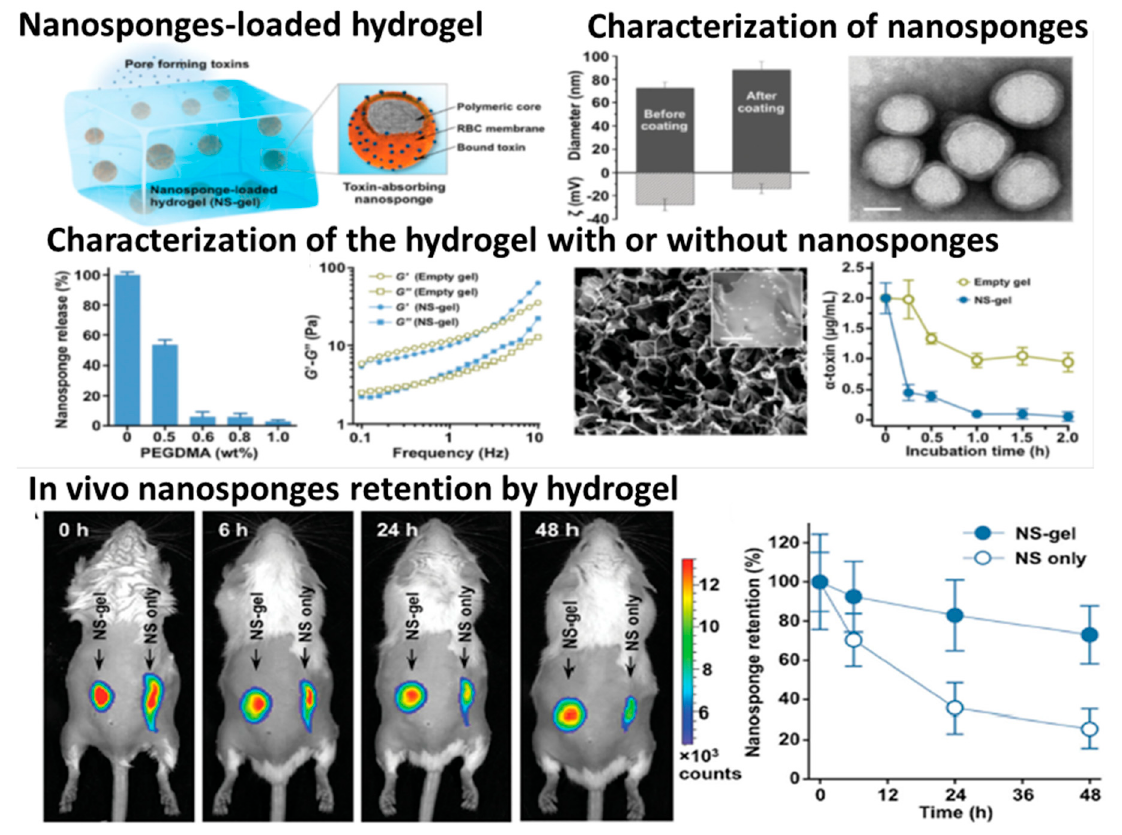
Figure 12. Schematic illustration of a hydrogel retaining toxin-absorbing nanosponges (NS-gel) for local treatment of bacterial infection. The toxin nanosponge was constructed with a poly(D,L-lactide-co-glycolide) (PLGA) core wrapped in natural red blood cell (RBC) bilayer membrane and was subsequently embedded into polyacrylamide (PAM) hydrogel, reproduced with permission from [396]. Copyright John Wiley and Sons, 2015.